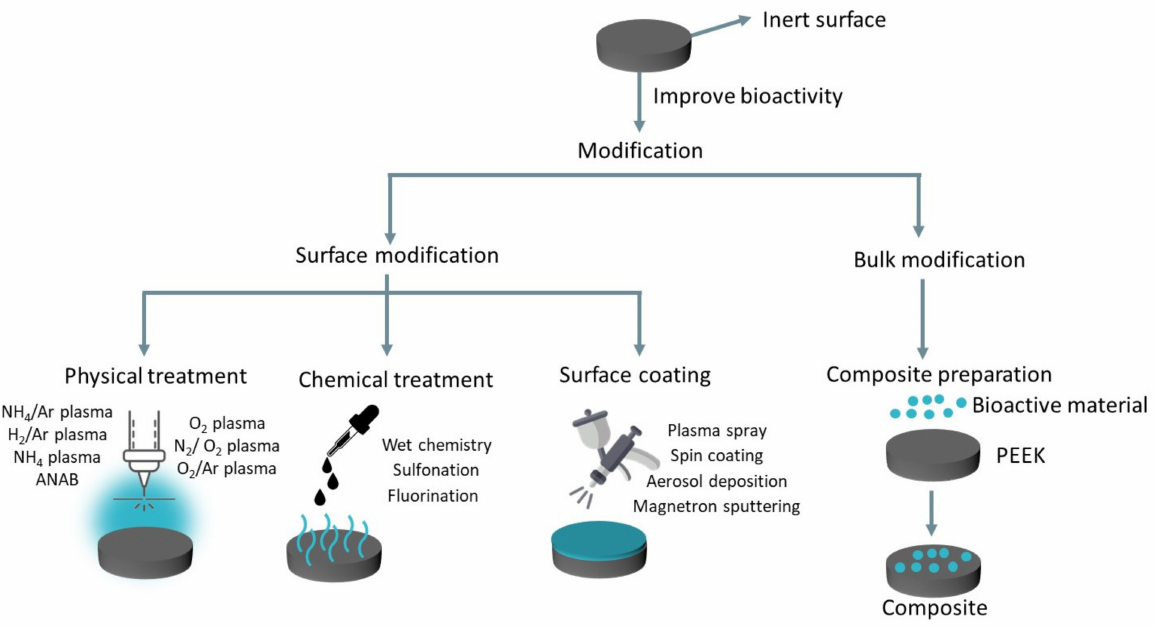
Figure 1. Techniques to improve the bioactivity of PEEK. Adapted with permission from [15]. Copyright 2014,